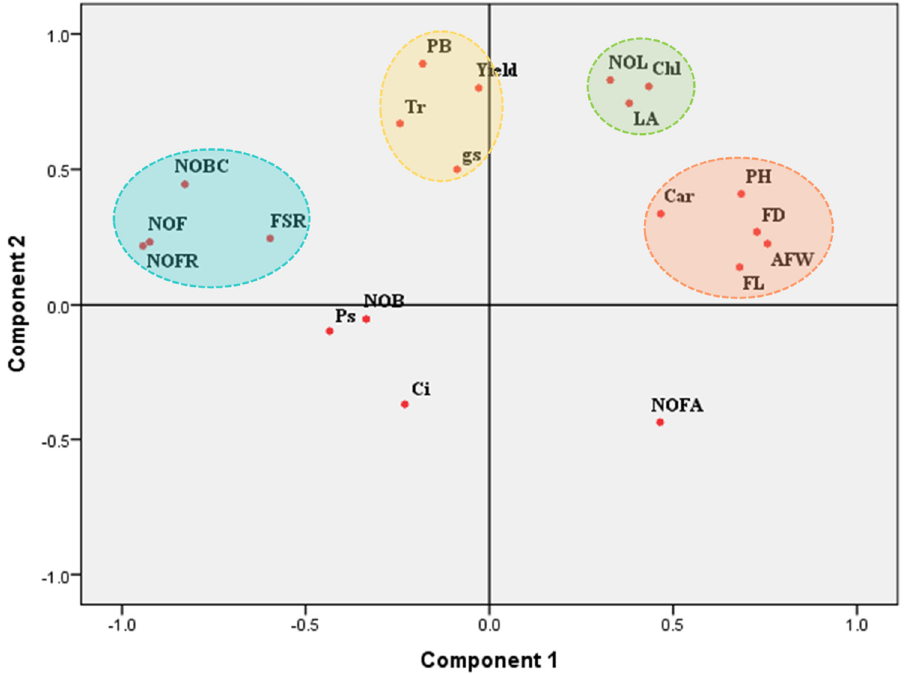
Figure 11. Principal component analysis (PCA) shows two main components for the relationship between growth, physiology and yield related attributes in tomato cultivars at the reproductive stage of the experiment. Abbreviations: AFW—average fruit weight; FSR—fruit setting ratio; NOL—number of leaves; LA—leaf area; Chl—Chlorophyll; Car—Carotenoid; NOF—number of flower; NOFR—number of fruits; NOB—number of bud cluster; NOBC—number of bud per cluster; NOFA—number of flower aborted; FL—fruit length; FD − fruit diameter; PH—plant height; PB—plant biomass; Ps—photosynthetic rate; gs—stomatal conductance; Ci—Internal CO 2 ; Tr—transpiration rate. Different colors of circles represent different groups of correlation.